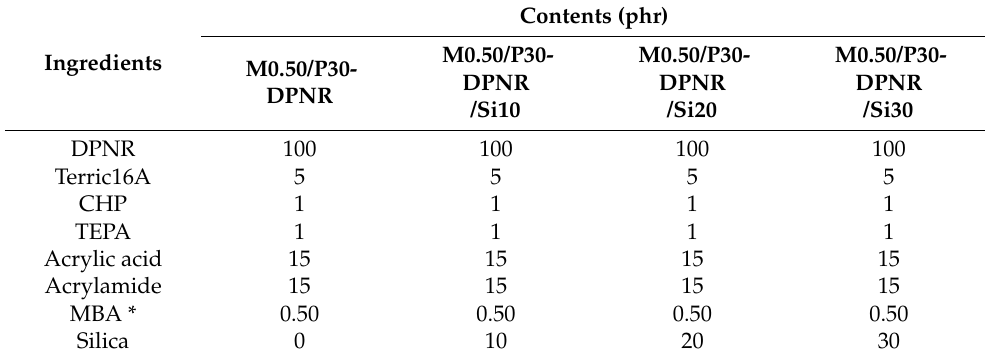
Table 1. Preparation of crosslinked (PAA- co -PAM)-DPNR/silica